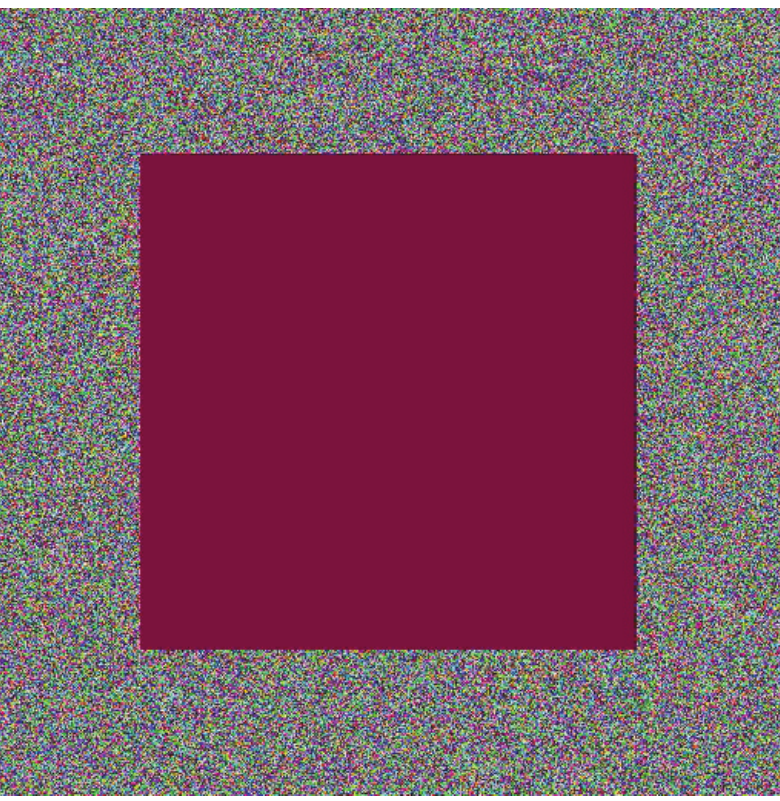
Figure 2. Occlusion noise in an encrypted image.